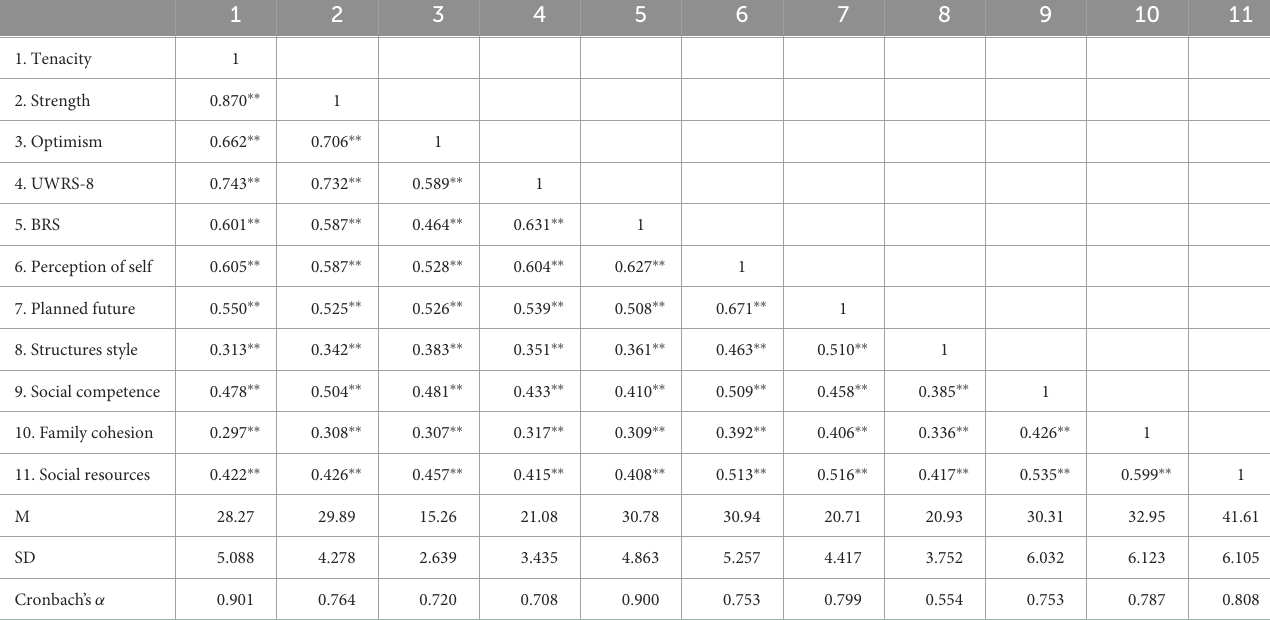
TABLE 2 Bivariate correlations (Pearson’s r ) among resilience variables ( N =